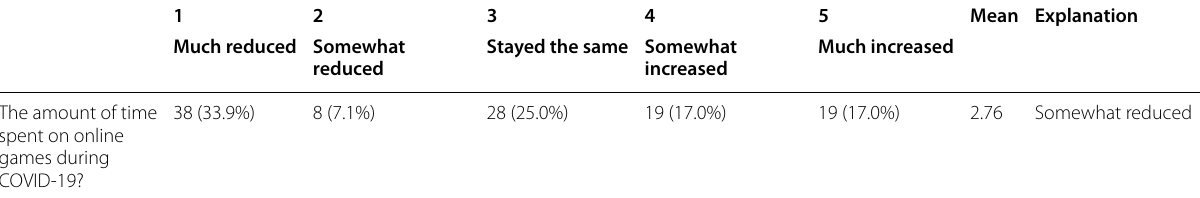
Table 3 ANOVA for age and COVID-19 lifestyles